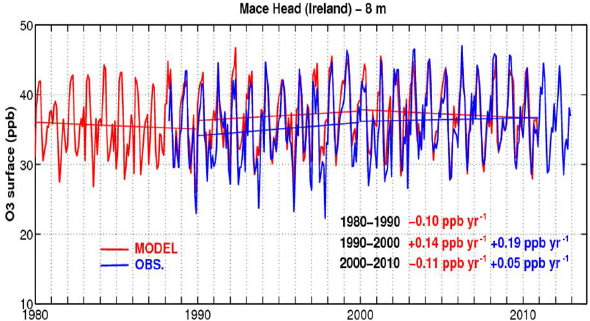
Figure 3. Monthly variation of surface ozone (ppbyear − 1 ) at the Mace Head station observed (blue) and modelled (red) in the Cam- Chem member of the Climate-Chemistry Model Initiative